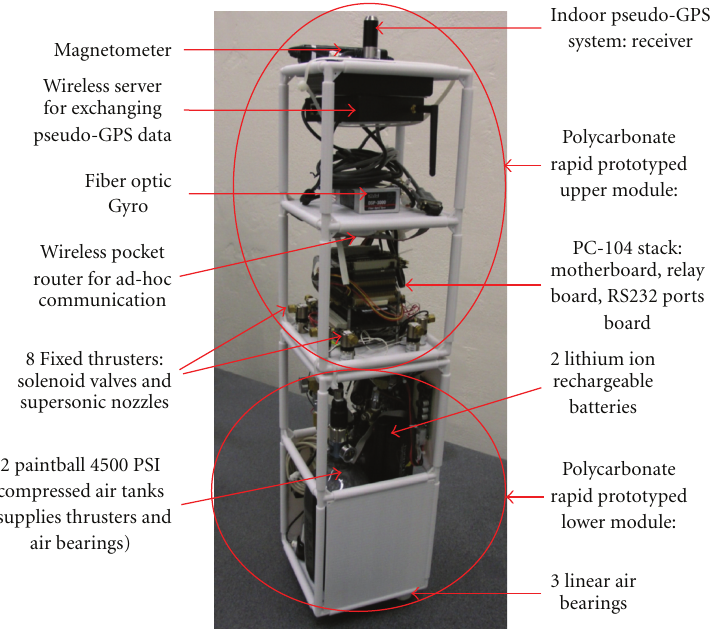
Figure 4: Detailed collocation of the hardware on the spacecraft